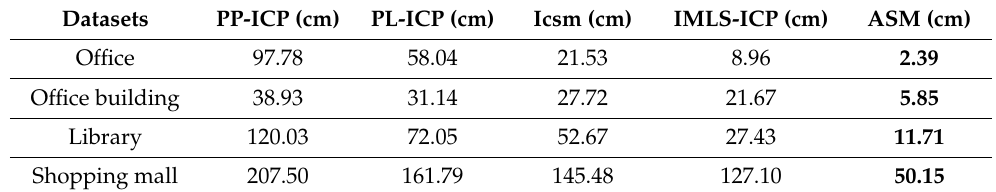
Table 1. End-to-end error statistics table.